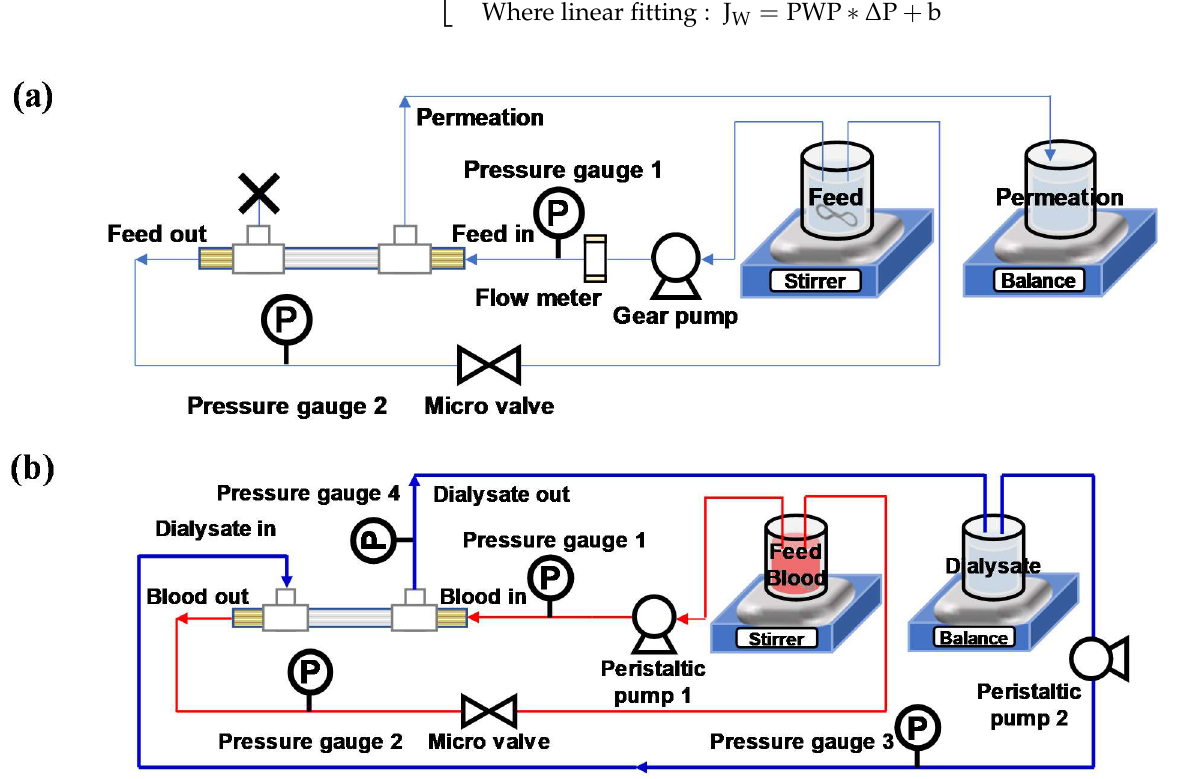
Figure 1. The schematic diagrams of ( a ) the hydraulic filtration system; ( b ) the closed-circulation urea clearance test system .